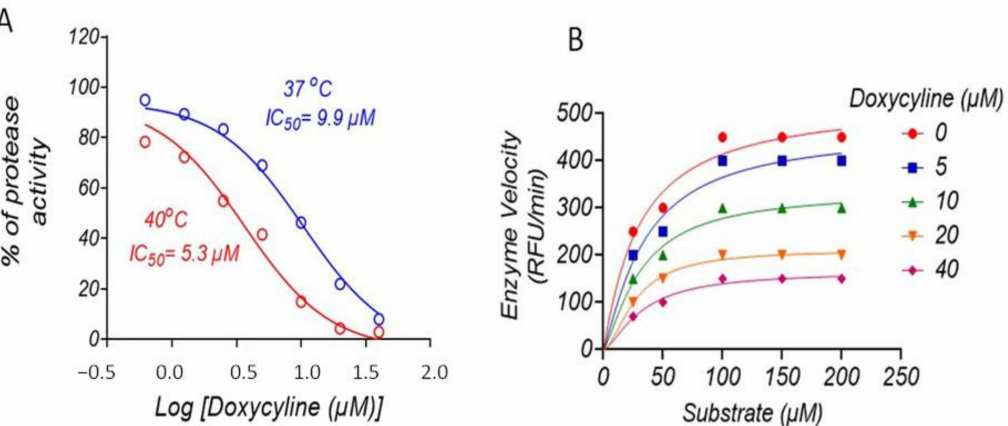
Figure 2. ZIKV NS2B-NS3pro protease assay. ZIKV NS2B-NS3 protease was produced as a recombinant protein by E. coli. The kinetic analysis of ZIKV NS2B-NS3 protease was performed in the presence and absence of doxycycline as an inhibitor at four different concentrations. ( A ) Doxycycline efficiently inhibited viral protease at 37 ◦ C and 40 ◦ C, which represent average human temperature (37 ◦ C) and human temperature at a high fever during virus infection (40 ◦ C). ( B ) Kinetic analysis of ZIKV NS2B-NS3 pro was performed in the presence and absence of doxycycline as an inhibitor at four different